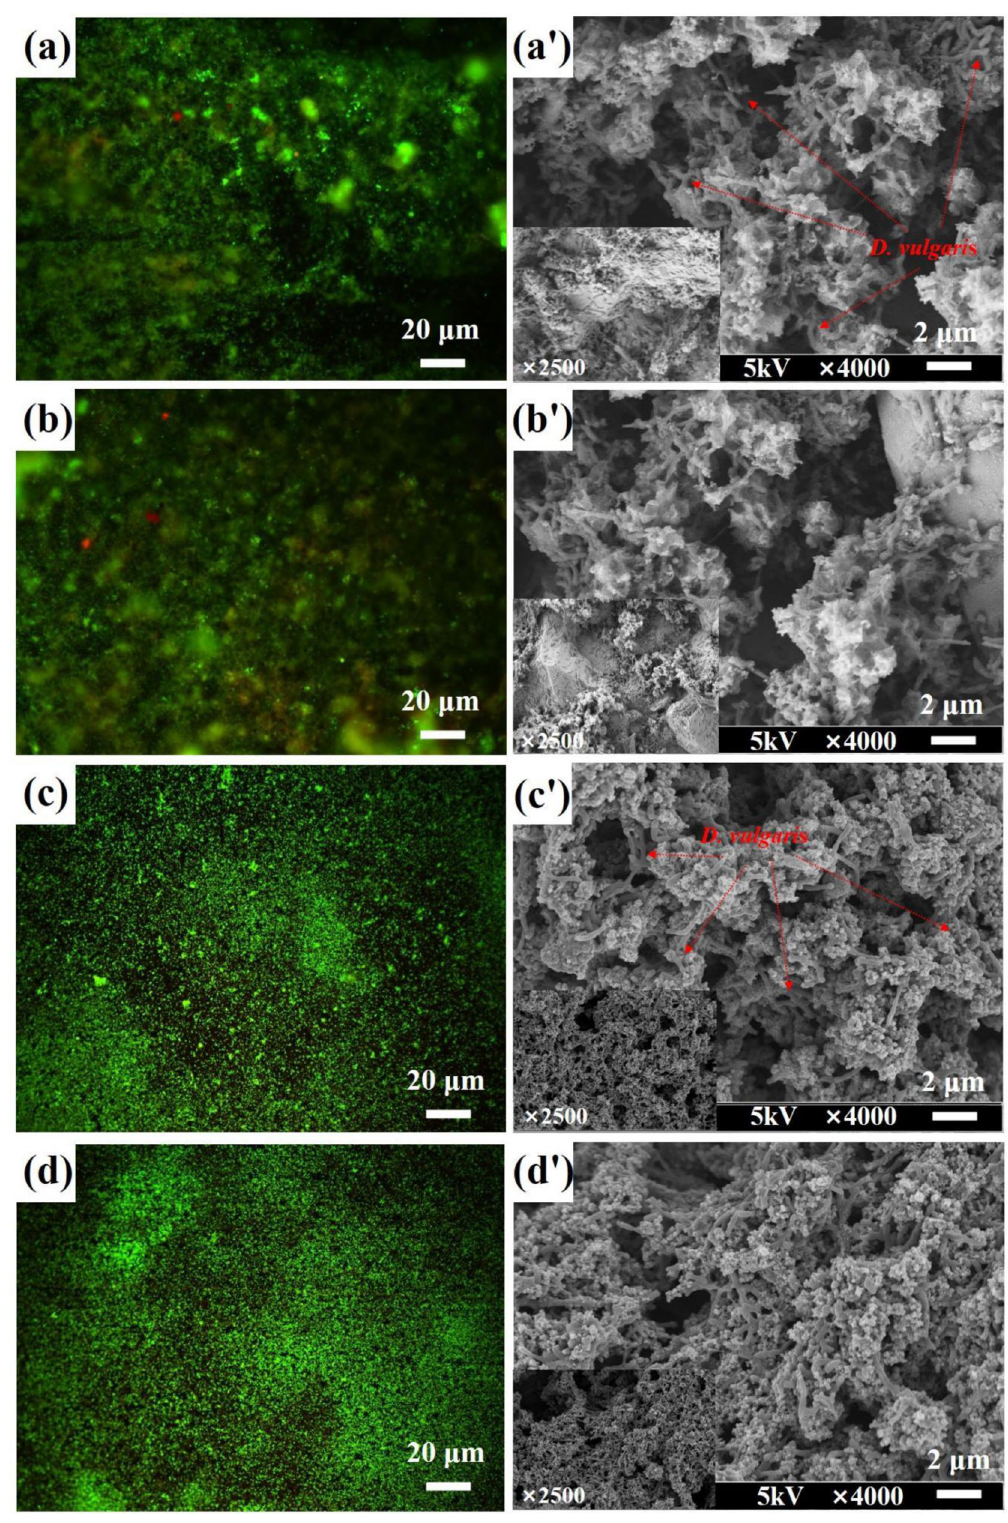
Fig. 2 D. vulgari s bio fi lm morphology. FM and SEM images of bio fi lms on Cu and Ni coupons after the 7-d incubation in the D. vulgari s media: a , a ' Cu + D. vulgaris only; b , b ' Cu + D. vulgari s + ribo fl avin; c , c ' Ni + D. vulgaris only; d , d ' Ni + D. vulgari s + ribo fl